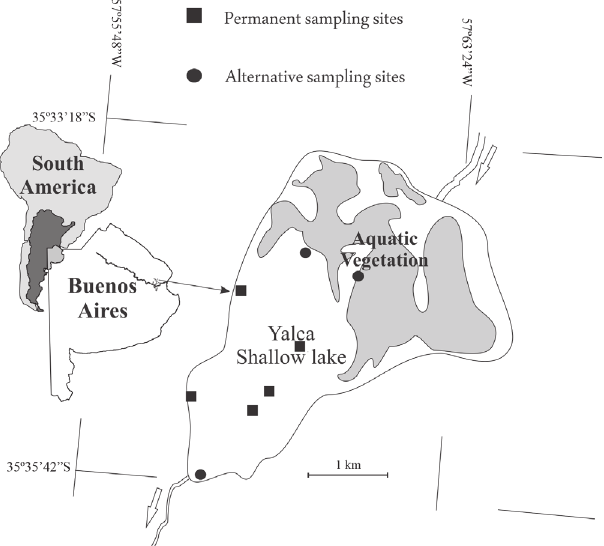
Fig. 1. Geographical location of Yalca Lake and its geographical position in south America. The sampling stations in the lake are